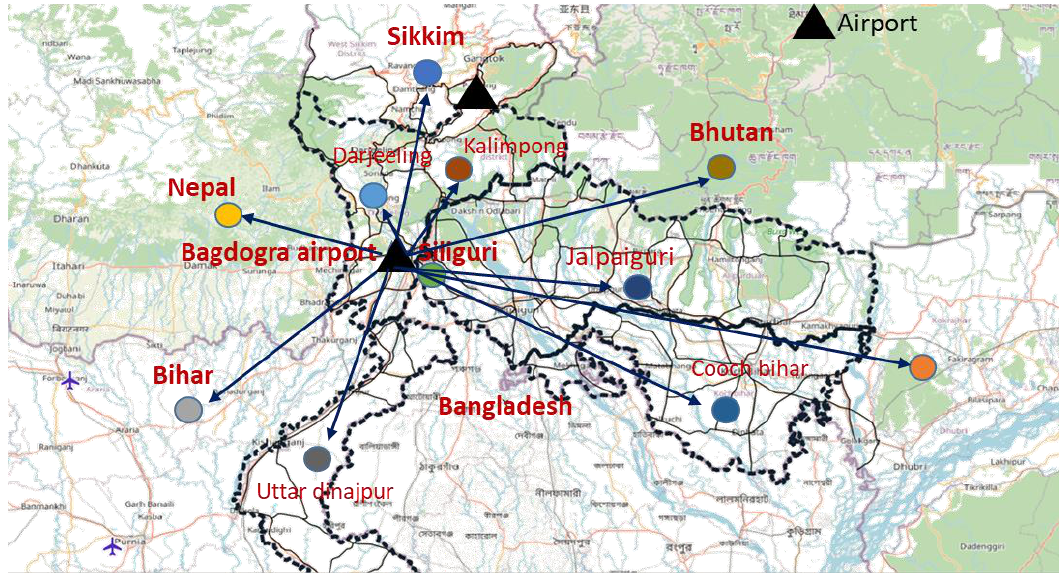
Figure 2. Areas served by Bagdogra Airport